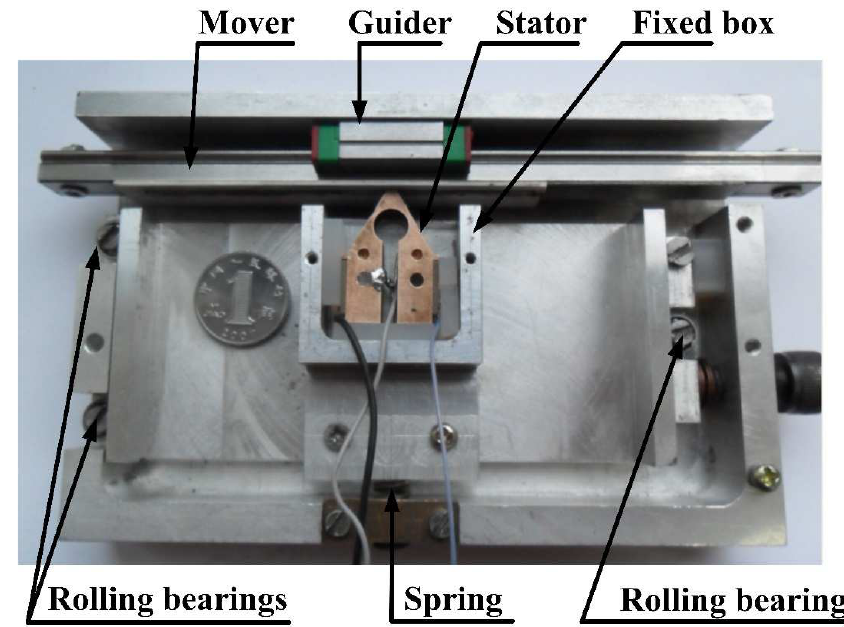
Figure 14. The actual motor.